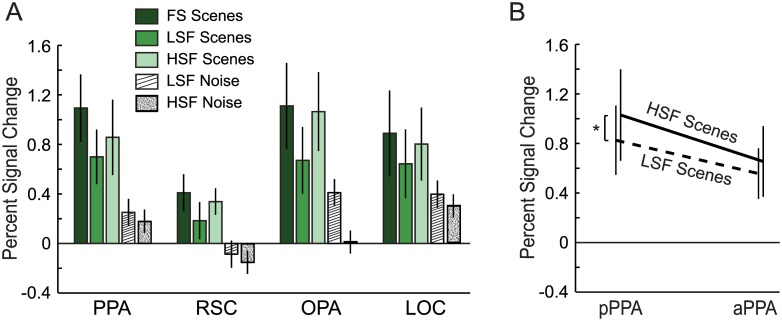
Percent signal change in visual ROIs.(A) Univariate activation of high-level visual ROIs by spatial frequency-filtered scenes and noise stimuli. (B) HSF scenes activate pPPA more strongly than LSF scenes. This difference does not persist in aPPA. Error bars are standard errors of the mean. *p < 0.05.